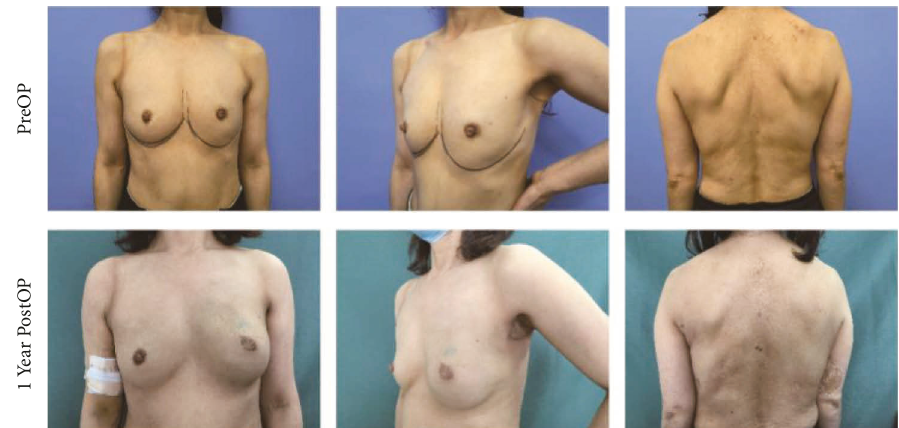
Figure 6: A 53-year-old woman undergoing LDMF combined with prosthesis breast reconstruction after E-SSM and E-LDMF harvesting with her preoperative photos and 1-year postoperative photos.